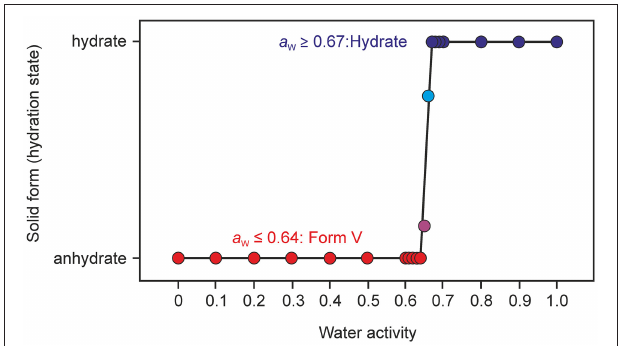
FIGURE 10 | Phase diagram after equilibration for 21 days showing the stability ranges of solid phases of DDS ( form V and the 0.33-Hy ) as a function of water activity in methanol/water mixtures at 25 ◦ C. Anhydrous form III was used as a starting phase; the phase identity and composition was determined with